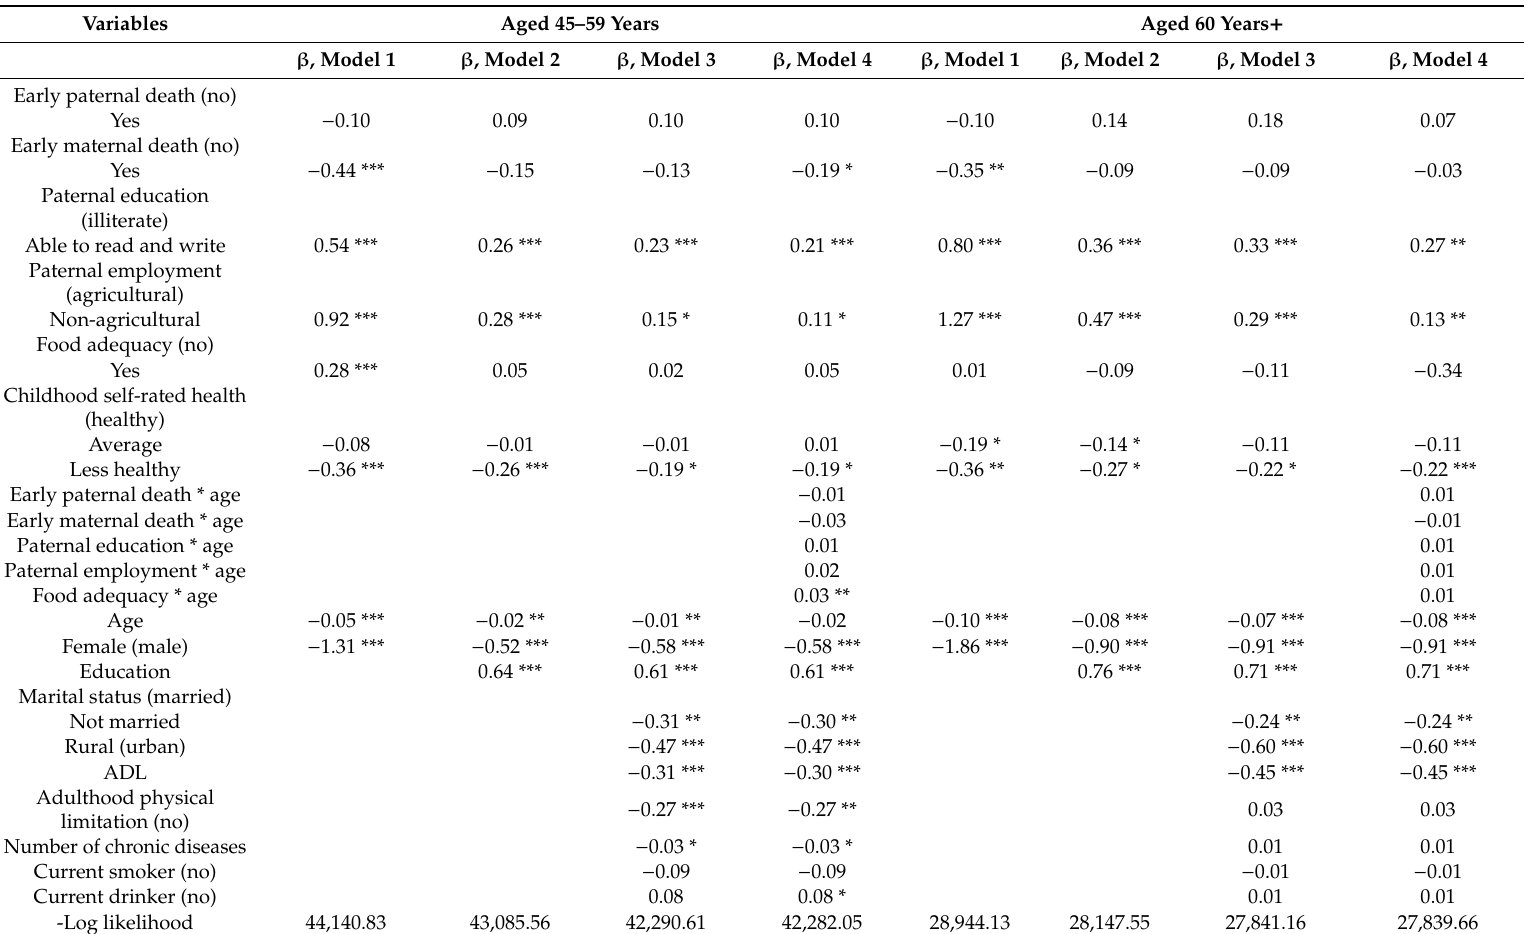
Table 3. Associations between early-life conditions (ELC) and mental intactness scores for middle- and old-aged Chinese adults.